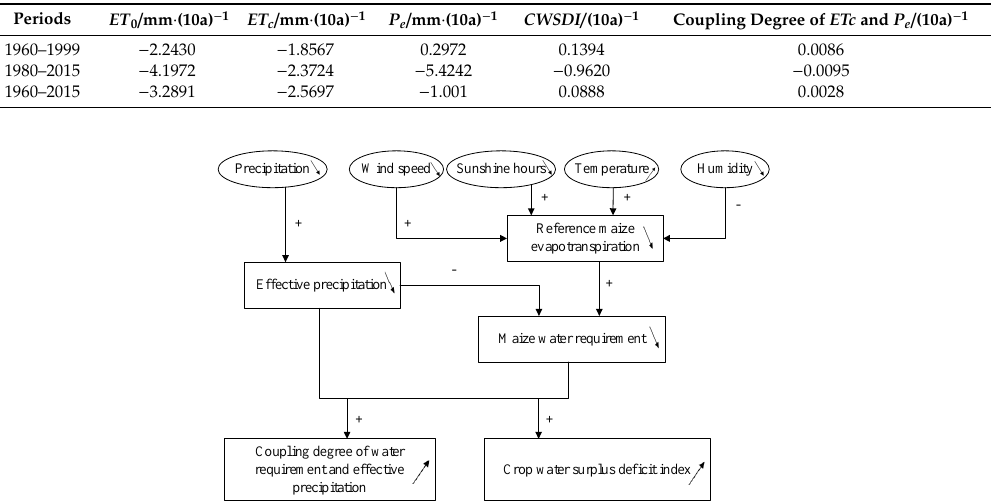
Table 3. Climate tendency rate of ET 0 , ET C , P e , CWSDI , and coupling degree of ET c and P e during the maize growing seasons of 1960–2015 in the study area.